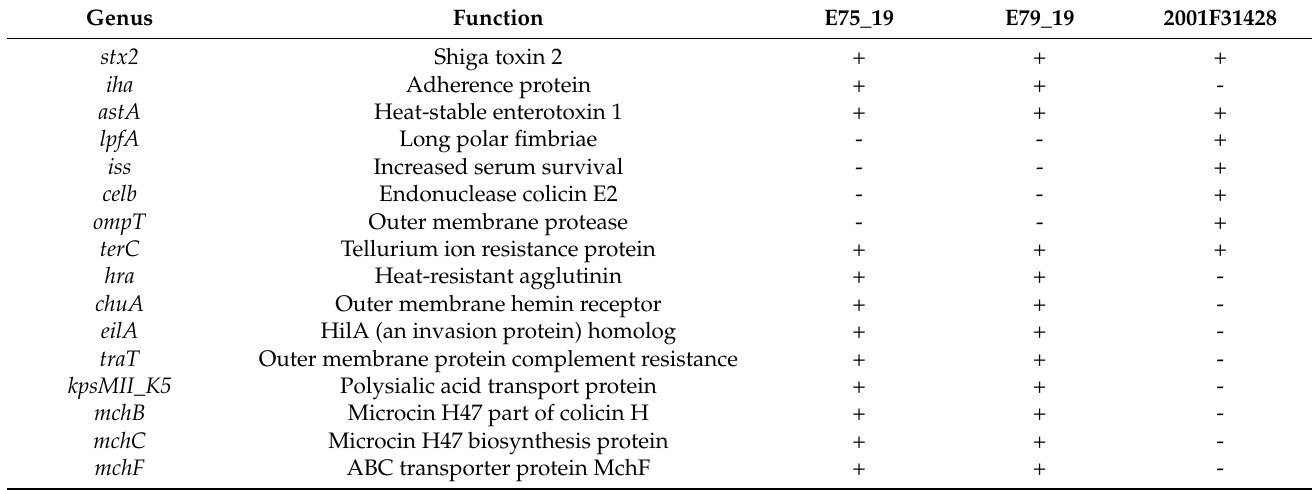
Table 3. Presence of virulence genes in three Stx2m-producing STEC